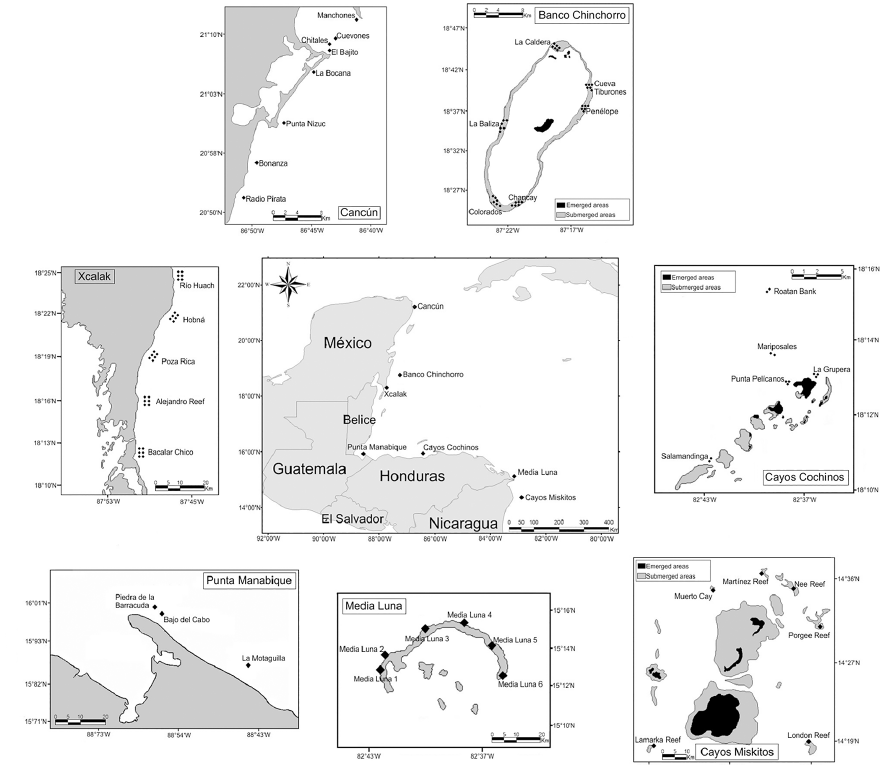
Fig 1. Study area with zones of coral reefs in the western Caribbean. Cancún, Banco Chinchorro, Xcalak, Punta Manabique, Cayos Cochinos Media Luna, Cayos